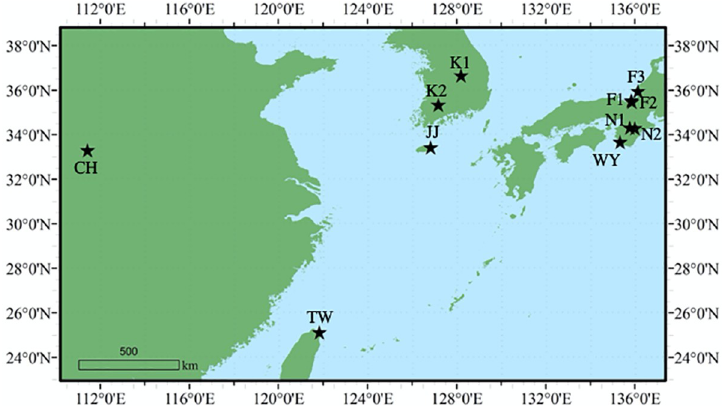
Fig 1. Sampling locations of 11 populations of M . fuliginosus in east Asia. The abbreviations of each sampling location are referred to Table